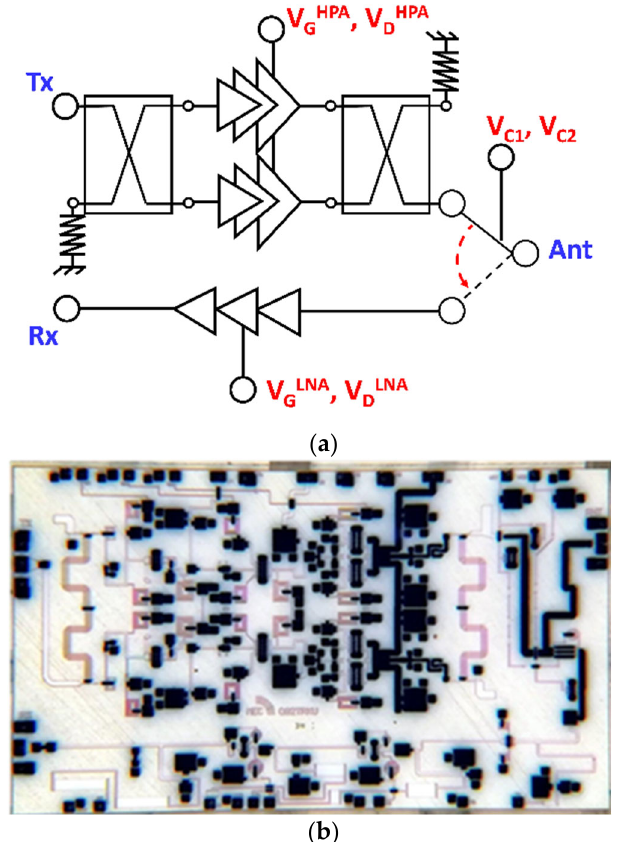
Figure 1. Ku-band SCFE architecture: ( a ) Schematic; ( b ) MMIC